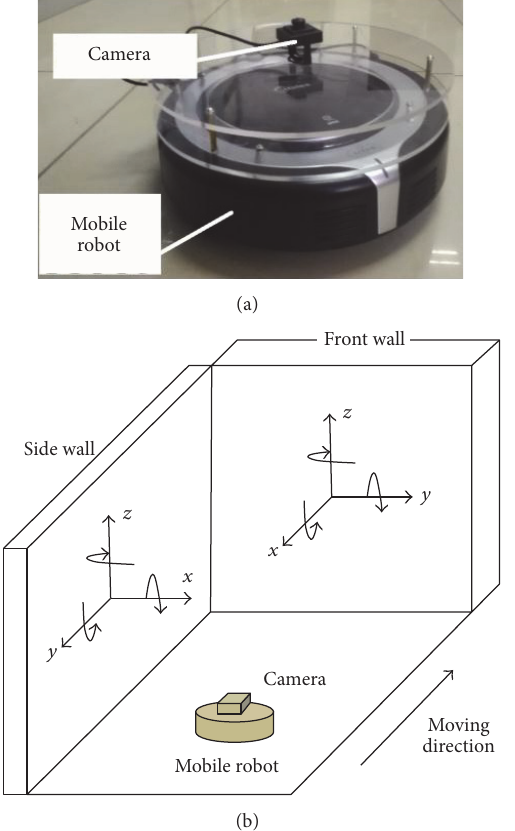
Figure 1: The relationship between wall and upward-looking cam- era. (a) Robot and camera. (b) Relationship between front wall and side wall and